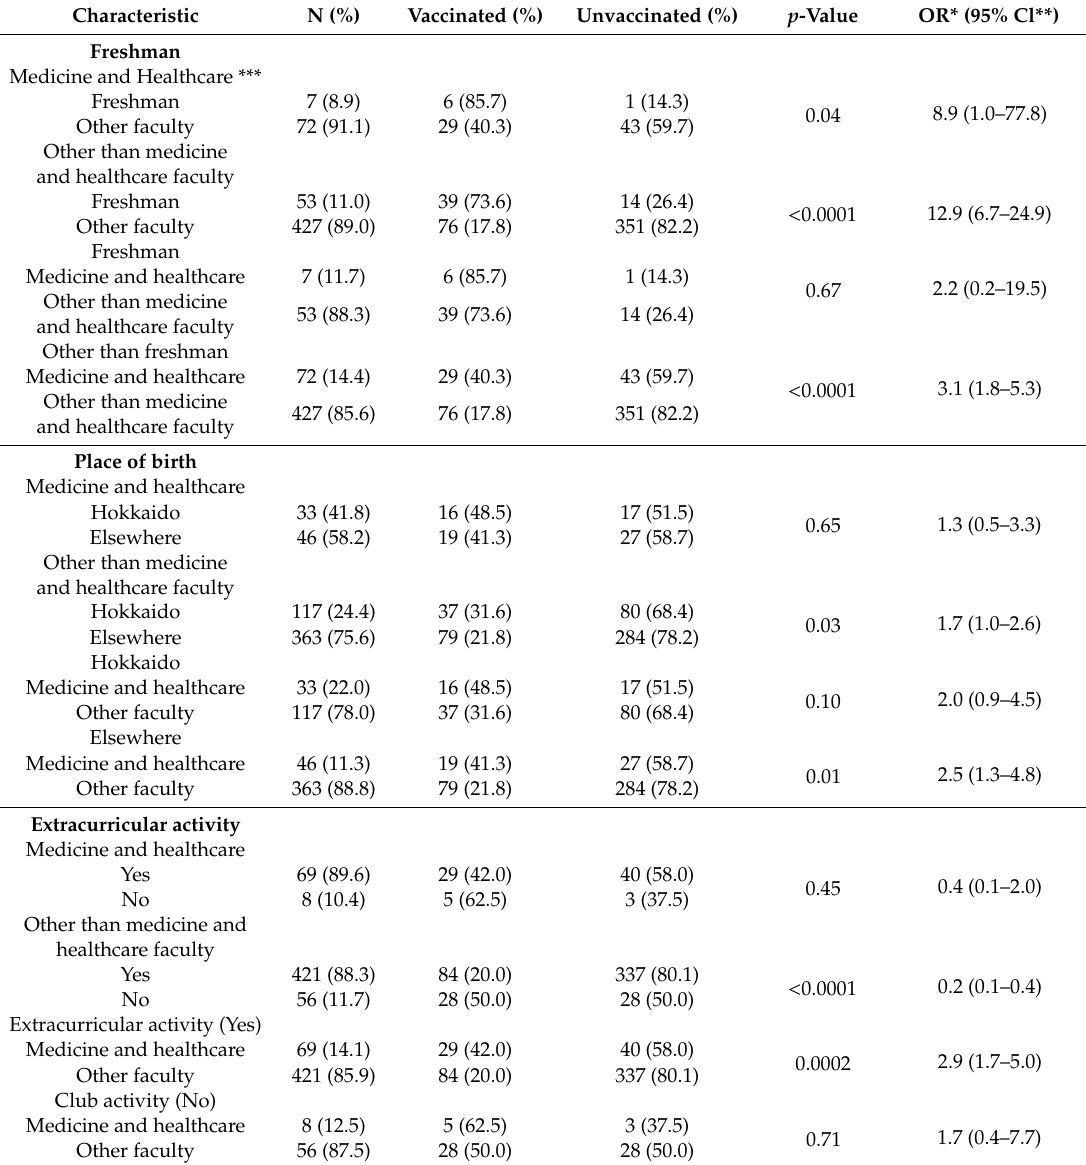
Table 4. Cross tabulation of vaccination frequency regarding grade / year, medicine and healthcare major, birthplace, and extracurricular